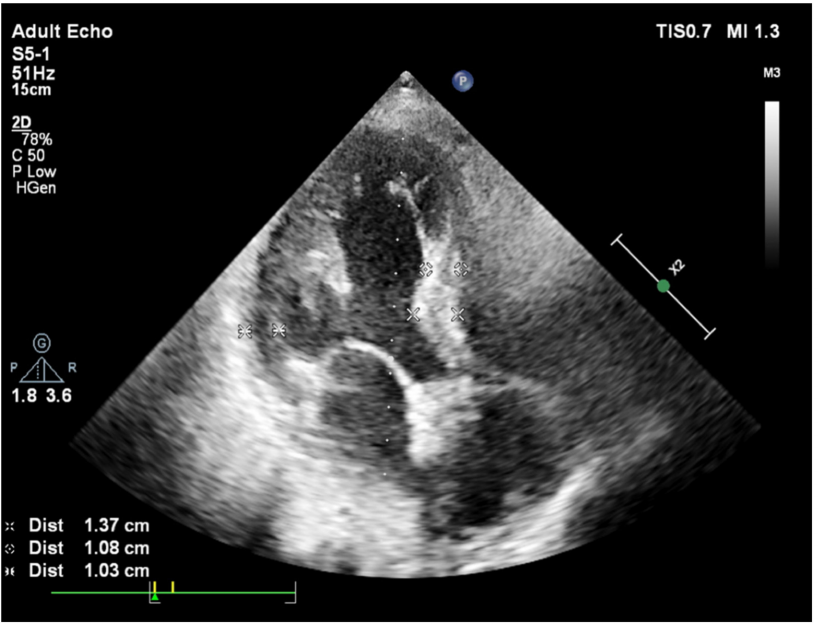
Figure 1. A slight curve of septal base from apical 4 chamber view during end-diastole in a patient with systemic hypertension and basal septal